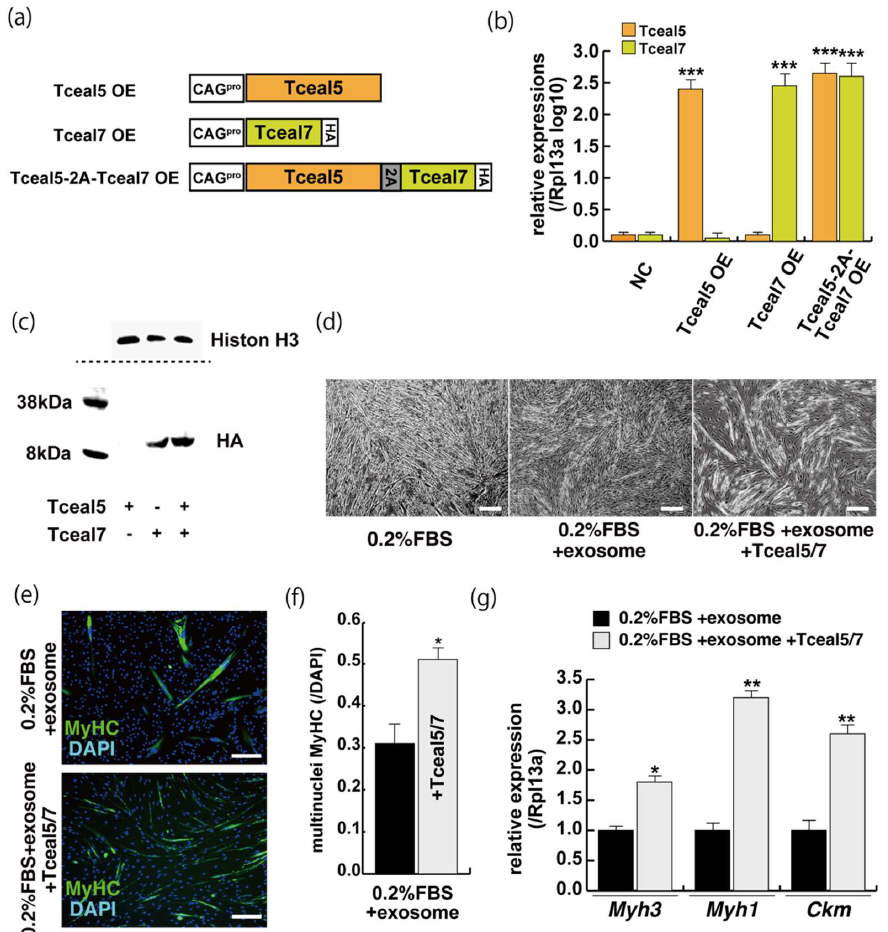
Figure 5. The upregulation of Tceal5/7 rescues differentiating myogenic cells repressed by exosome. ( a ) Representation of DNA constructs for overexpression of mouse Tceal5 (Tceal5 OE), HA-tagged Tceal7 (Tceal7 OE), and both genes (Tceal5-2A-Tceal7 OE); ( b ) RT-qPCR analyses with Tceal5 and/or Tceal7 overexpressing in C2C12 cells; ( c ) Western blot analyses with Tceal5 and/or Tceal7 overex- pressing 293 cells. Histone H3 was used as a loading control; ( d ) morphological changes with both Tceal5 and Tceal7 overexpression in differentiated C2C12 cultures in the presence of additional ex- osomes; ( e ) differentiated C2C12 cells treated with additional exosomes and Tceal5/7 overexpres- sions, were immunostained with anti-MF20 (MyHC, green). All nuclei were stained with 4′6-dia- midino-2-phenylindole (DAPI, blue); ( f ) The ratio of DAPI-positive multinuclei staining present in single MyHC-positive myofibers with additional exosomes and Tceal5/7 overexpression; ( g ) relative RT-qPCR of mature myogenic transcripts (Myh1, Myh3, Ckm) in differentiating muscle cells with exo- somes and Tceal5/7; All Scale bar = 100 μm. Data represent means ± SEM ( n = 3). The statistical analysis was performed by Mann–Whitney U test. * p < 0.05, ** p < 0.01, *** p < 0.001. 3 . Discussion s Proliferation and terminal differentiation of myogenic cells are usually mutually ex- clusive. When growing myogenic cells are induced to differentiate by being placed in a